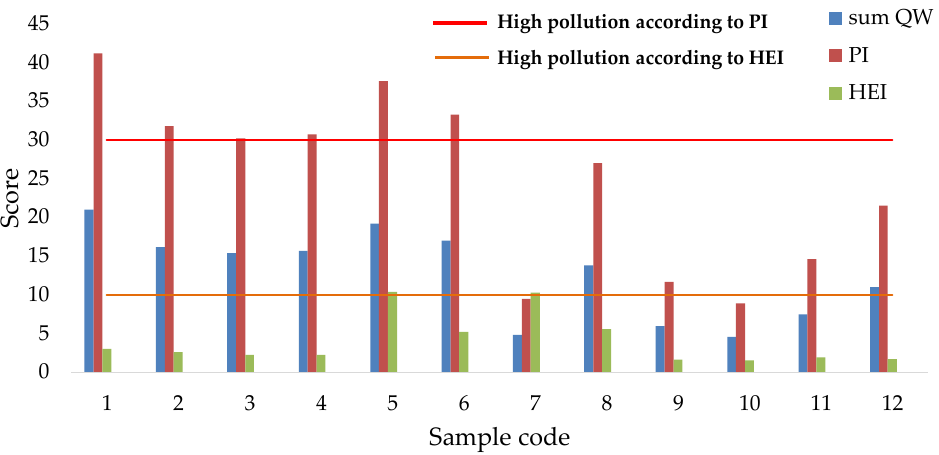
Figure 6. PI and HEI scores and the corresponding pollution level of the studied water samples.